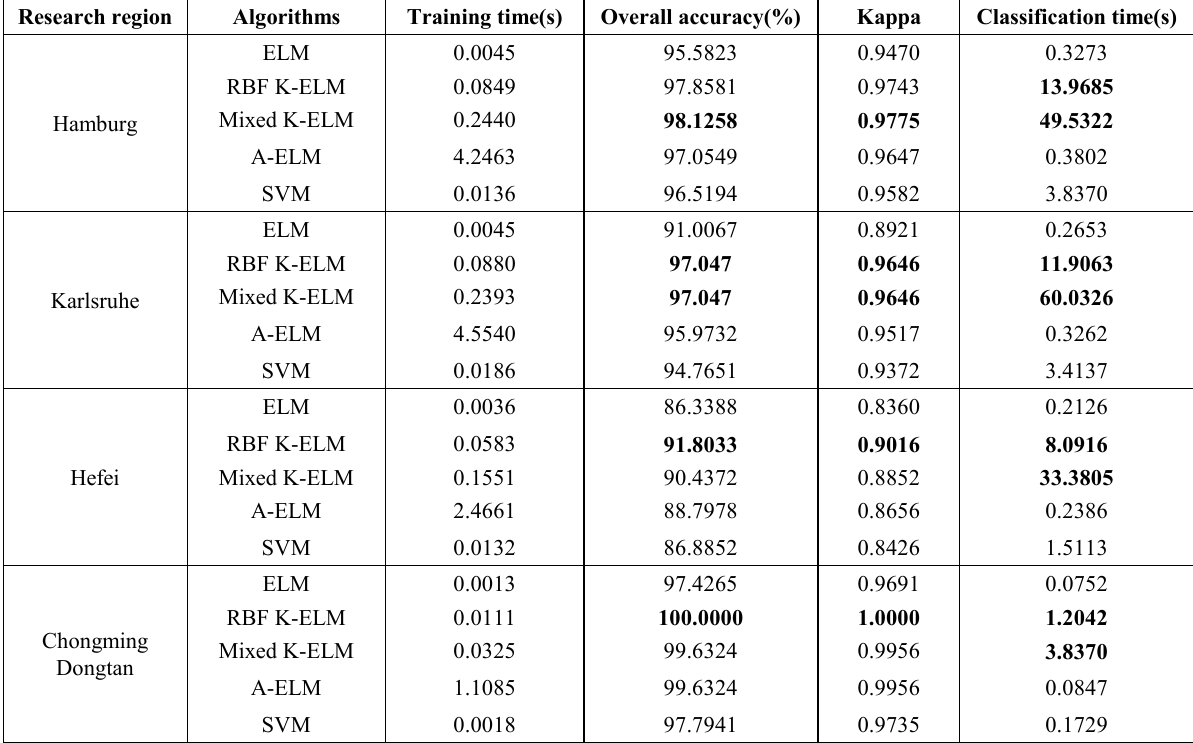
Table 2. Performance evaluation of different